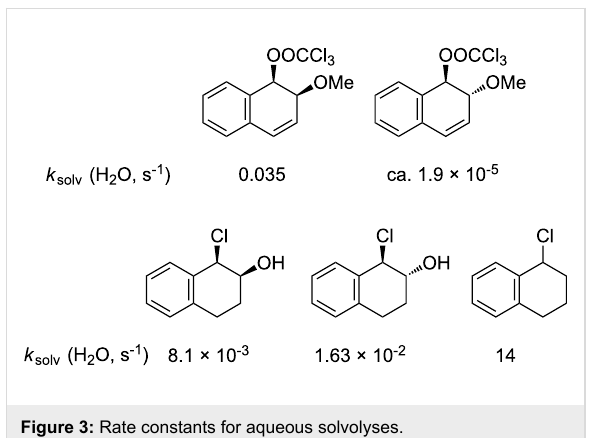
Figure 3: Rate constants for aqueous solvolyses.